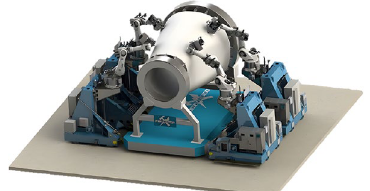
Figure 14 Mobile multi-machine collaborative manufacturing system of